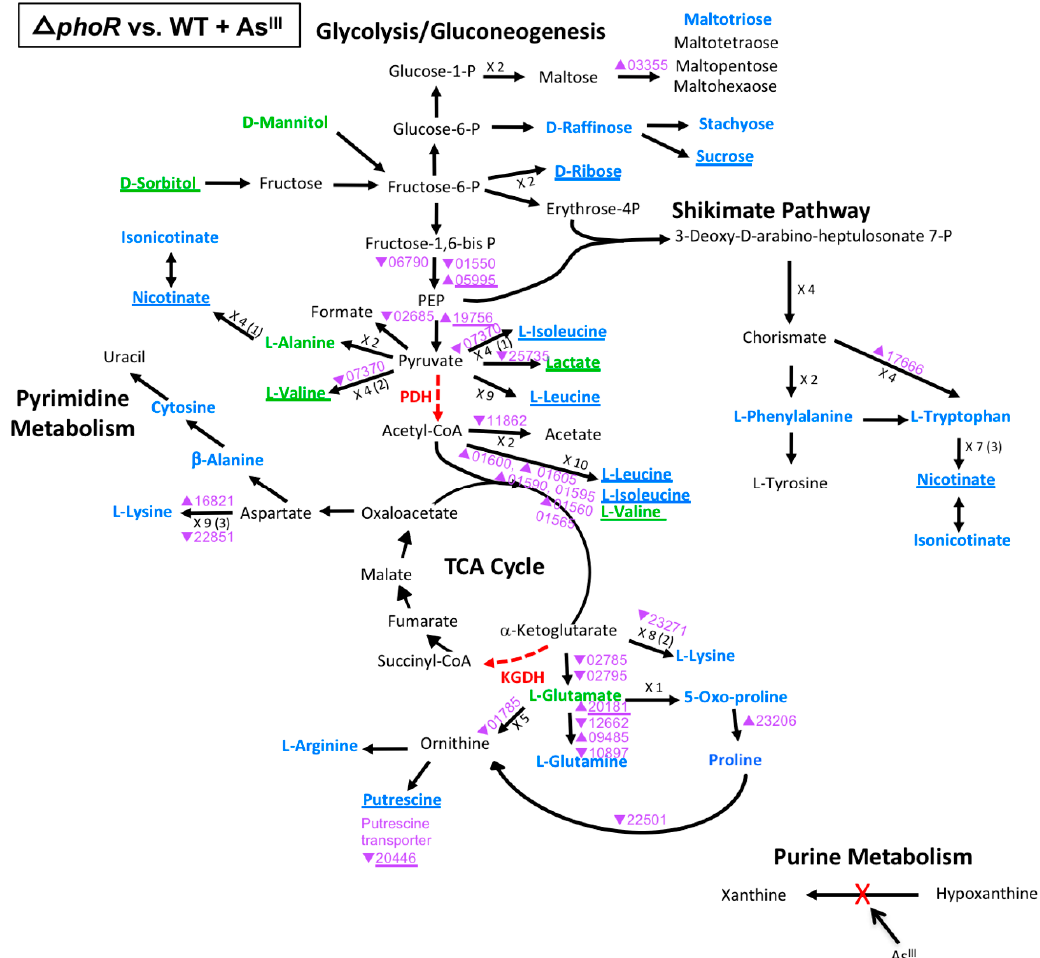
Figure 5. Model of carbon metabolism in the ∆ phoR mutant vs WT during As III exposure, with mannitol being the initial substrate. Reaction steps were derived from KEGG pathway maps using the most parsimonious routes of metabolite formation, noting that not all enzyme reaction steps are depicted in the model. When multiple intermediates are involved between illustrated metabolites, the number of reactions is shown; i.e., × 3, with the number of intermediates identified shown in parentheses. Green text denotes metabolites increased in abundance; blue text denotes metabolites decreased in abundance. Red dashed vector arrows indicate reactions suggested to be inhibited by AsIII. Transcripts are denoted by AT5A identification number (purple text), with a triangle indication increased expression ( ← ) or decreased expression ( ↔ ). Underlined text indicates metabolites or transcripts for which the change in abundance when compared to the WT was the same with or without AsIII.